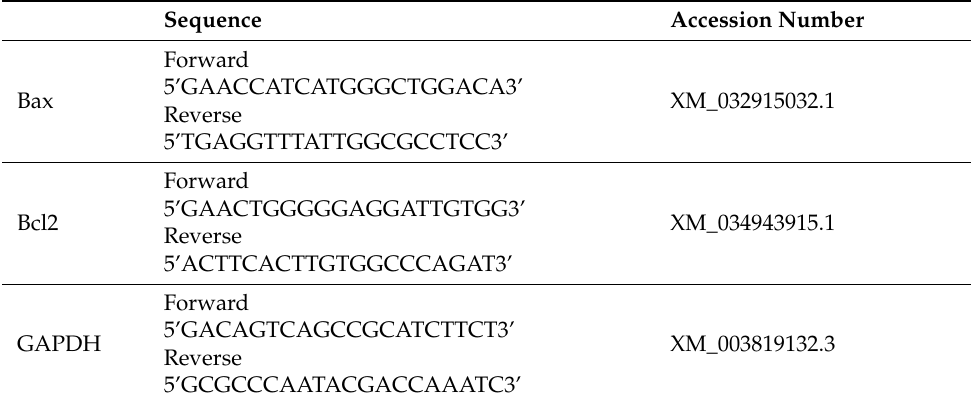
Table 1. Primer sequence for